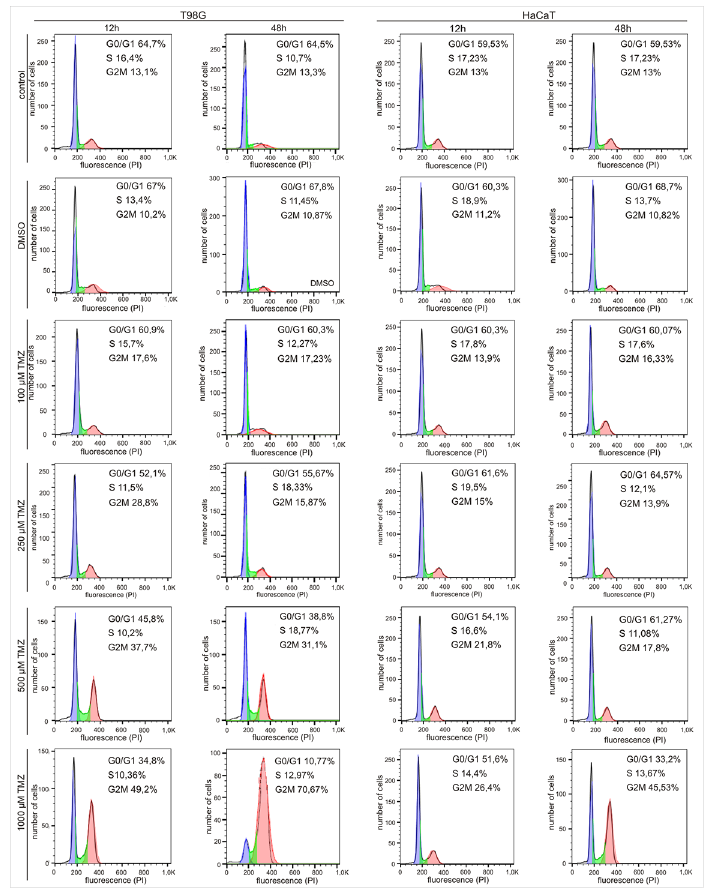
Fig 5. The effect of TMZ on the cell cycle. Cell cycle phases distribution in human glioblastoma (T98G) versus non cancer (HaCaT) cell lines after 12 and 48h temozolomide (TMZ) treatment was carried out using FACS calibur flow cytometer by DNA staining with propidium iode. TMZ treatment resulted in G2M phase arrest in both tested cell lines in a dose dependent